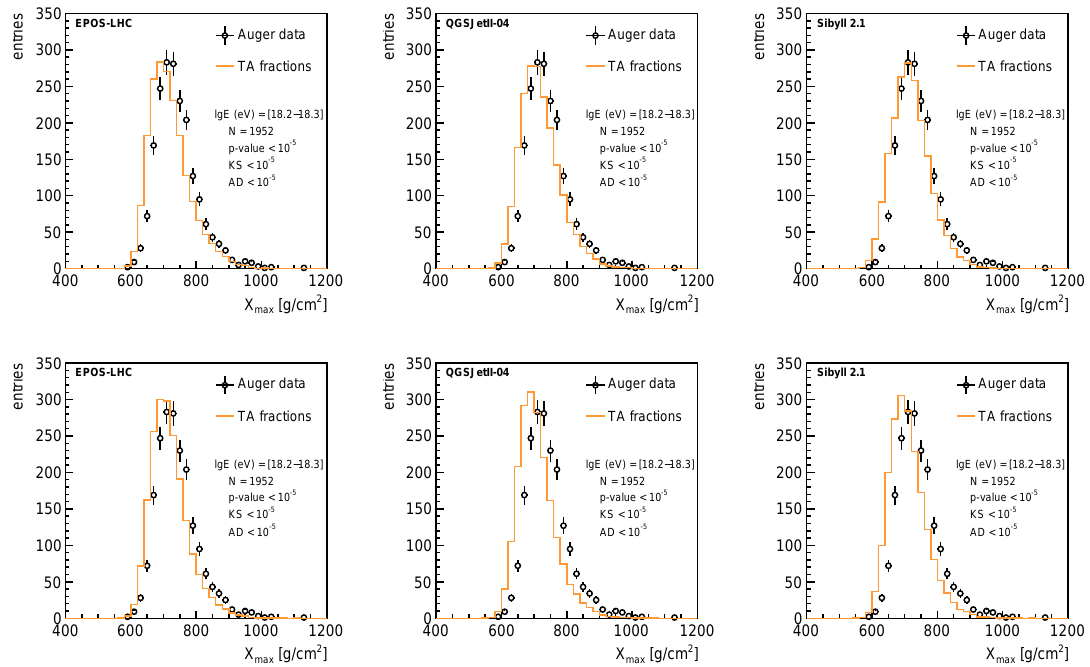
→ Auger max in the energy interval